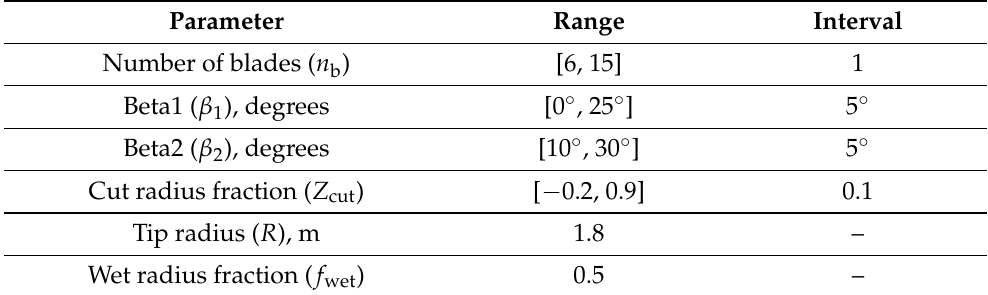
Table 2. Range of input parameters for the present study, selected partly based on the results presented in